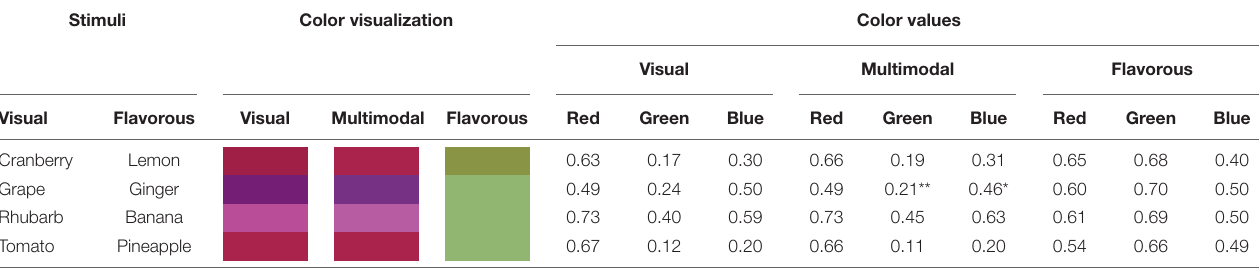
TABLE 2 | Color values in red, green, blue format, and visualization of the perceived colors for the color modulation task, significance marks represent the comparison between the visual and the multimodal cues (** p < 0.01, * p < 0.05).